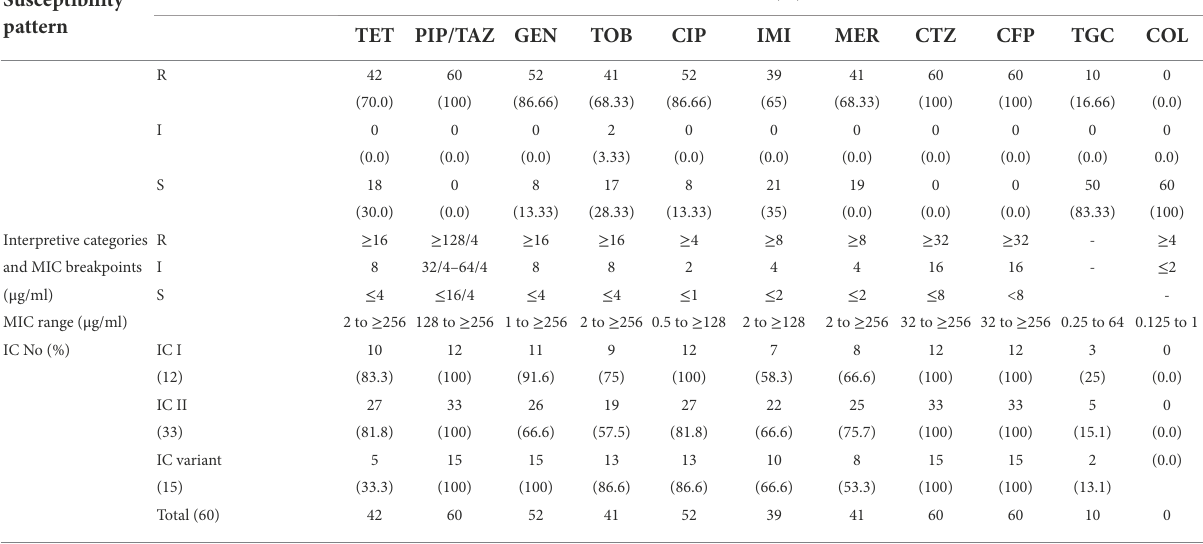
TABLE 1 Antibiotic susceptibility pattern of 60 A. baumannii isolates using MIC determination against 11 different antibiotics. Susceptibility